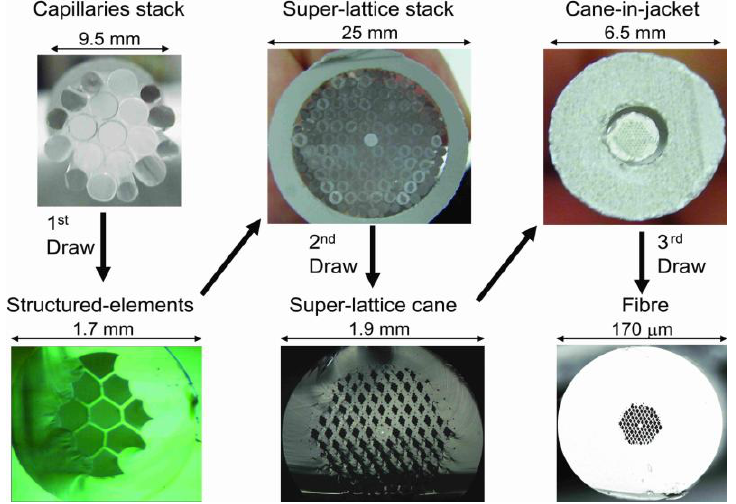
Figure 2. Photos of stacks and canes to illustrate the structured-element-stacking method (the illuminated Ge-doped area can be seen in the core of the superlattice